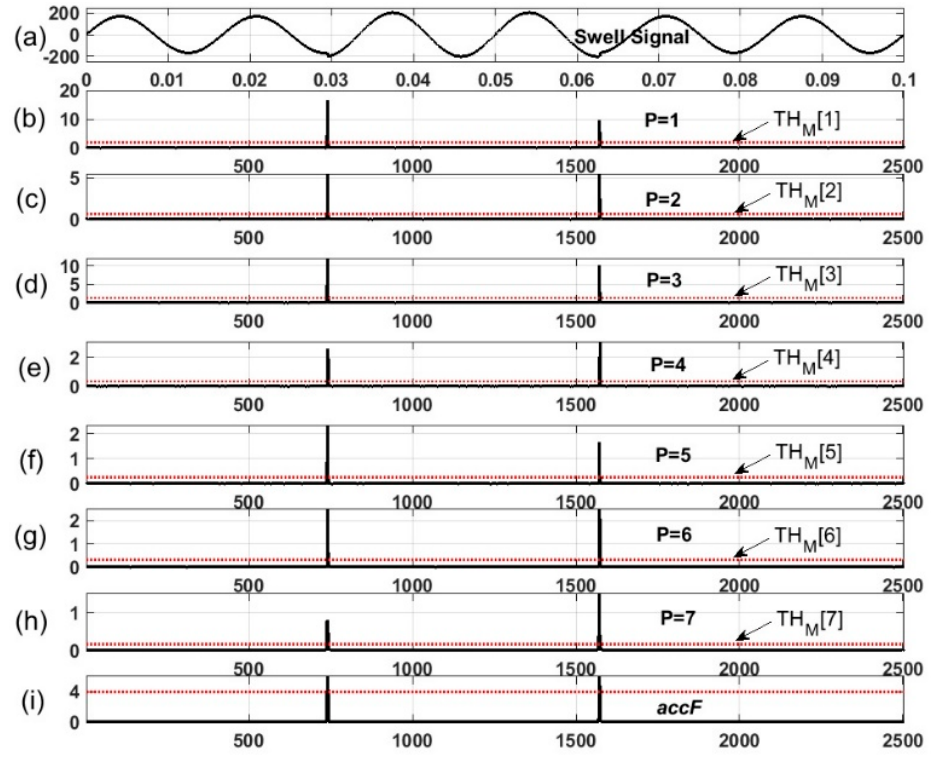
Figure 5. Snapshots of WPTM-based detection using MV: ( a ) voltage swell signal with 110% pu , ( b ) wavelet packet W 1 , ( c ) W 2 , ( d ) W 3 , ( e ) W 4 , ( f ) W 5 , ( g ) W 6 , ( h ) W 7 , ( i ) result of MV detection ( accF ).